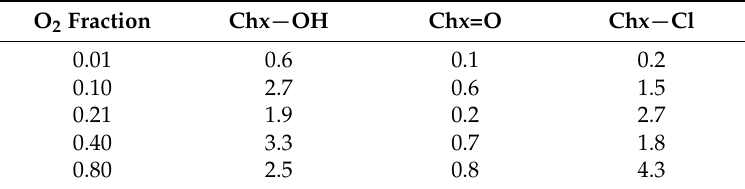
Table 3. Yields ( µ mol) of cyclohexanol, cyclohexanone, and chlorocyclohexane following a